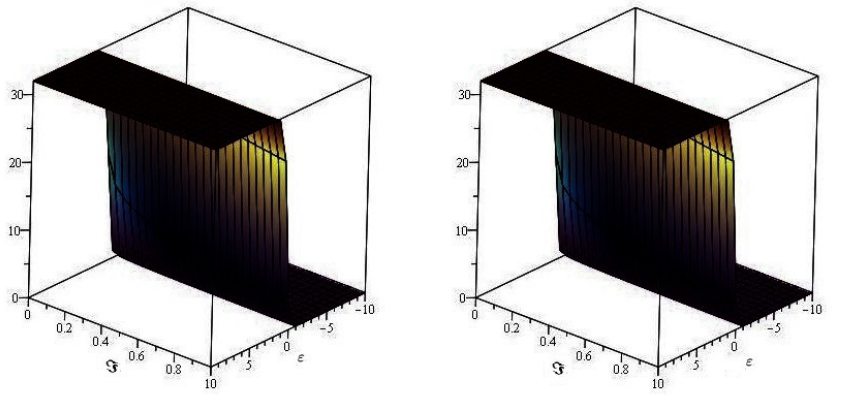
Figure 2. The actual and YDM solution of V ( ε , (cid:61) ) at ℘ = 1 of Example